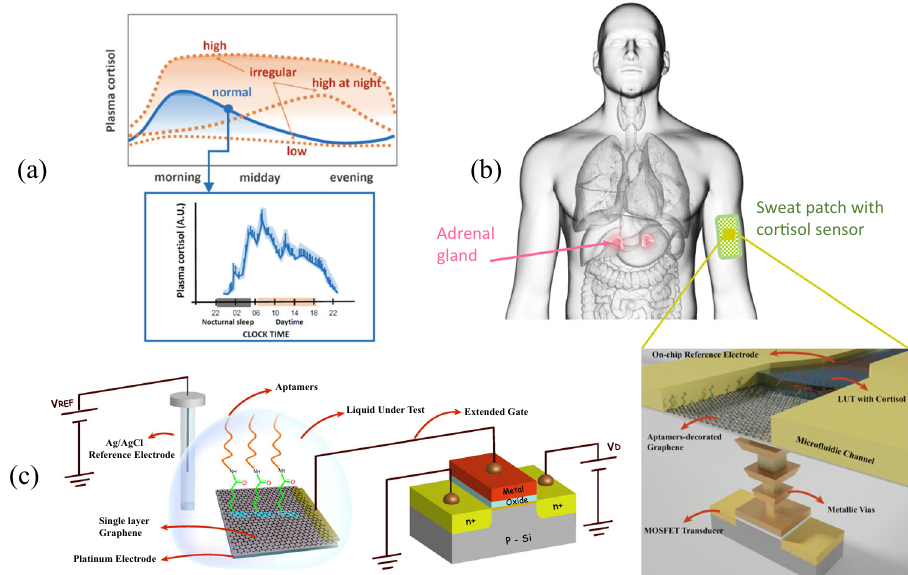
Fig. 1 Cortisol circadian rhythm and sensing principle of the extended-gate FET con fi guration for its measurement in a wearable patch. a Qualitative depiction of regular and irregular circadian levels of the cortisol produced by the adrenal glands in human body through the day, showing the need for high time granularity measurements to capture the pulsatile nature of cortisol, b concept of 3D-integrated cortisol sensor embedded in a patch used as wearable on the upper arm: at the bottom, the FET gate is extended through metal vias to a top metal layer covered with aptamer-decorated graphene. The system includes a top micro fl uidic channel that guides the sweat (LUT) over an integrated planar reference electrode and the functionalized graphene. c Schematic of extended-gate FET con fi guration used in this work: the functionalized electrode is electrically connected to the gate of the MOSFET transducer and immersed in the measurement solution while the extended-gate electrode is biased via the voltage applied on the reference